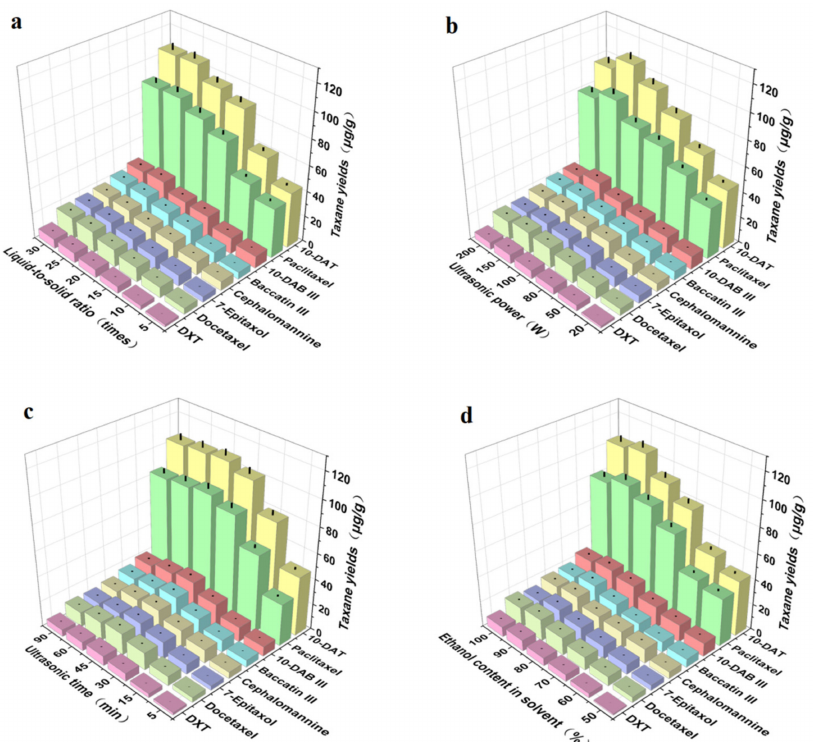
Figure 4. Effects of ( a ) liquid-to-solid ratio, ( b ) ultrasonic power, ( c ) ultrasonic time, ( d ) ethanol content in solvent on extraction yields of the eight main taxanes in Taxus cuspidata ( p <